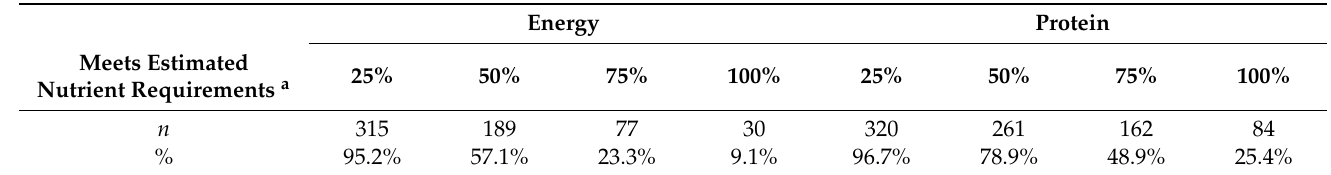
Table 2. The number and percentage of participants meeting estimated nutrient requirements. Energy